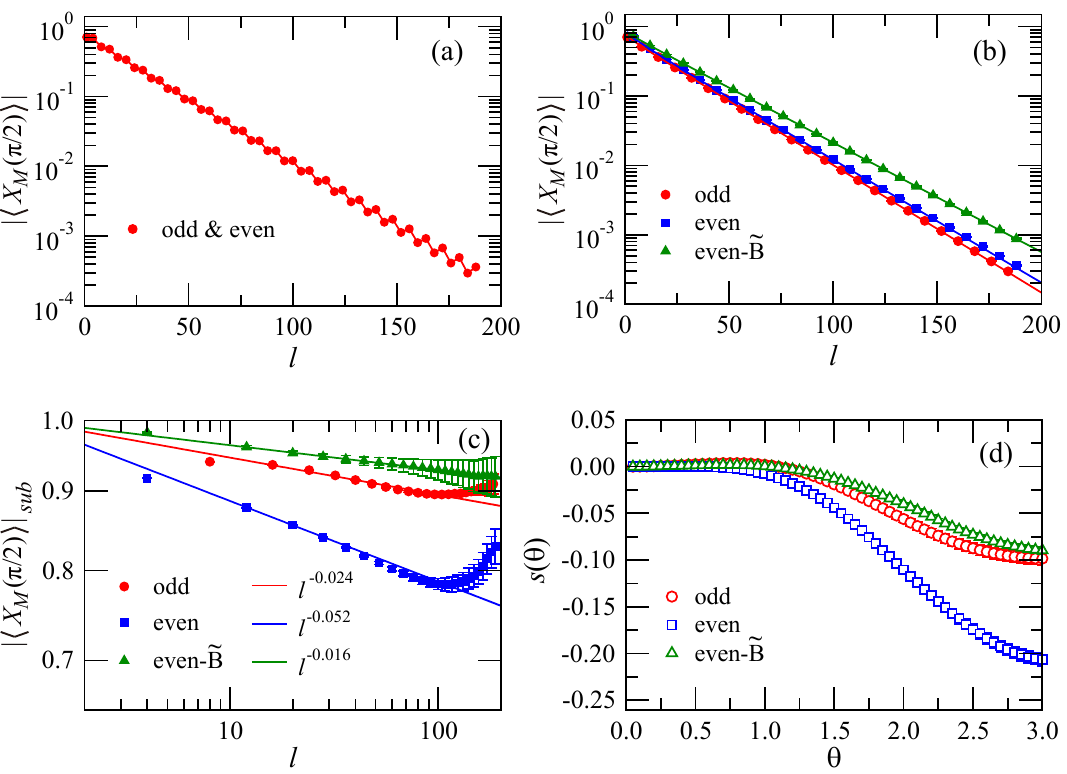
( θ ) 〉| for the H Figure 9: |〈 X model at DQC, all with L = 96: (a) (b) the disorder M J − Q 3 ( θ ) 〉| parameter and (c) its subleading term |〈 X as functions of l for θ = π/ 2 for M sub the three types of the region M , respectively. (d) s ( θ ) for the three types of the region M , respectively. It is interesting to note here that all three different types of M lead to negative s ( θ ) when θ is close to π